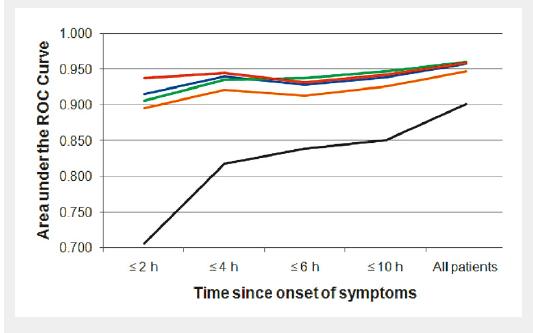
Diagnostic accuracy at presentation as quantified by the area under the receiver operating characteristic (ROC) curves for a contemporary cardiac troponin (cTn) assay (black, 4th generation cTnT) and four sensitive or high-sensitive cTn assays (red – Siemens cTnI Ultra; blue – Abbott cTnI Architect; green – Roche high-sensitivity cTnT; orange – Roche cTnI) in the diagnosis of acute myocardial infarction according to chest pain